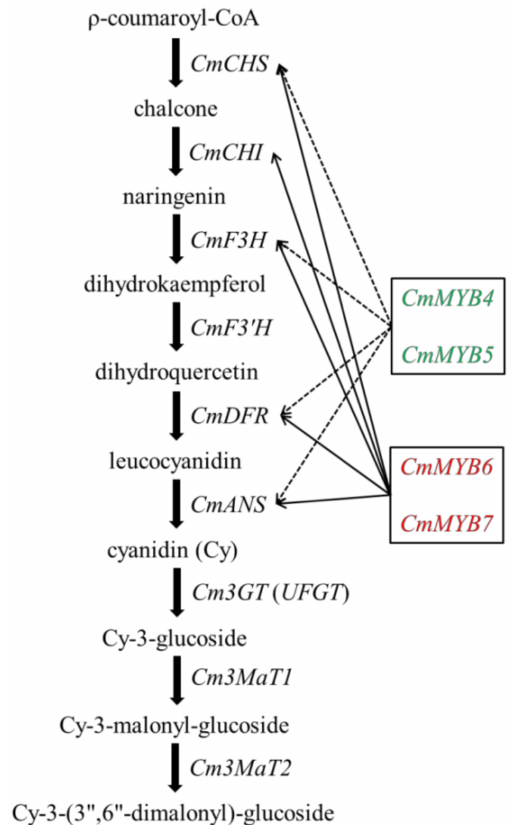
Figure 5. The inferred regulatory network of the anthocyanin biosynthetic pathway in the chrysanthemum. CmMYB4 and CmMYB5 negatively (marked by green with dashed line) regulate the expression of structural genes CmCHS , CmF3H , CmDFR , and CmANS , and correspondingly suppress the biosynthesis and accumulation of anthocyanins in the chrysanthemum capitulum. On the contrary, the expressions of CmCHS , CmCHI , CmF3H , CmDFR , and CmANS are positively regulated by CmMYB6 and CmMYB7 (marked by red with full line) and therefore promote the biosynthesis and accumulation of